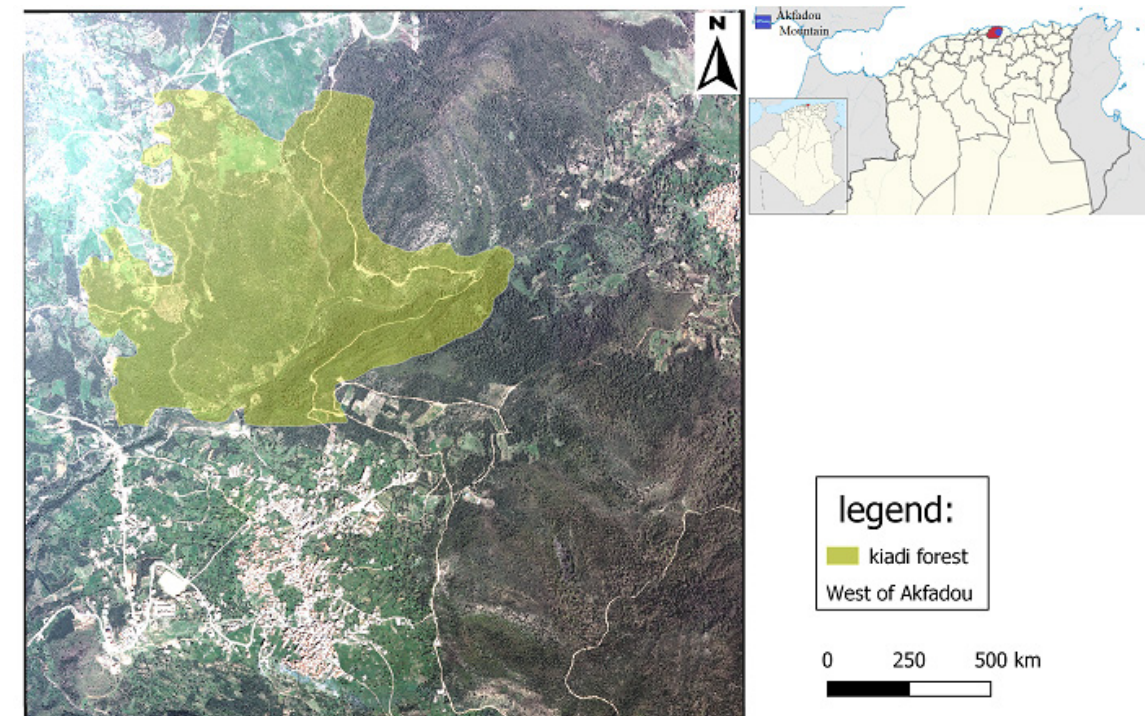
Figure 1. Study area (Kiadi cork oak forest, Akfadou, Tizi-Ouzou, Algeria)